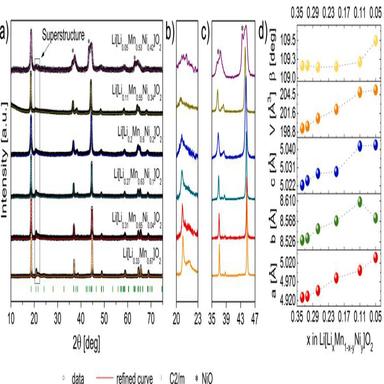
a) XRD patterns with Rietveld refinement of cathode materials with different Ni content, b) a detailed intensity of the superstructure reflection peaks at 2θ between 20◦ and 23◦ and c) intensity of reflection peaks at 2θ between 35◦ and 47◦ revealing NiO phase in LiO2, d) Unit cell parameters of Li O2 obtained using Rietveld technique.